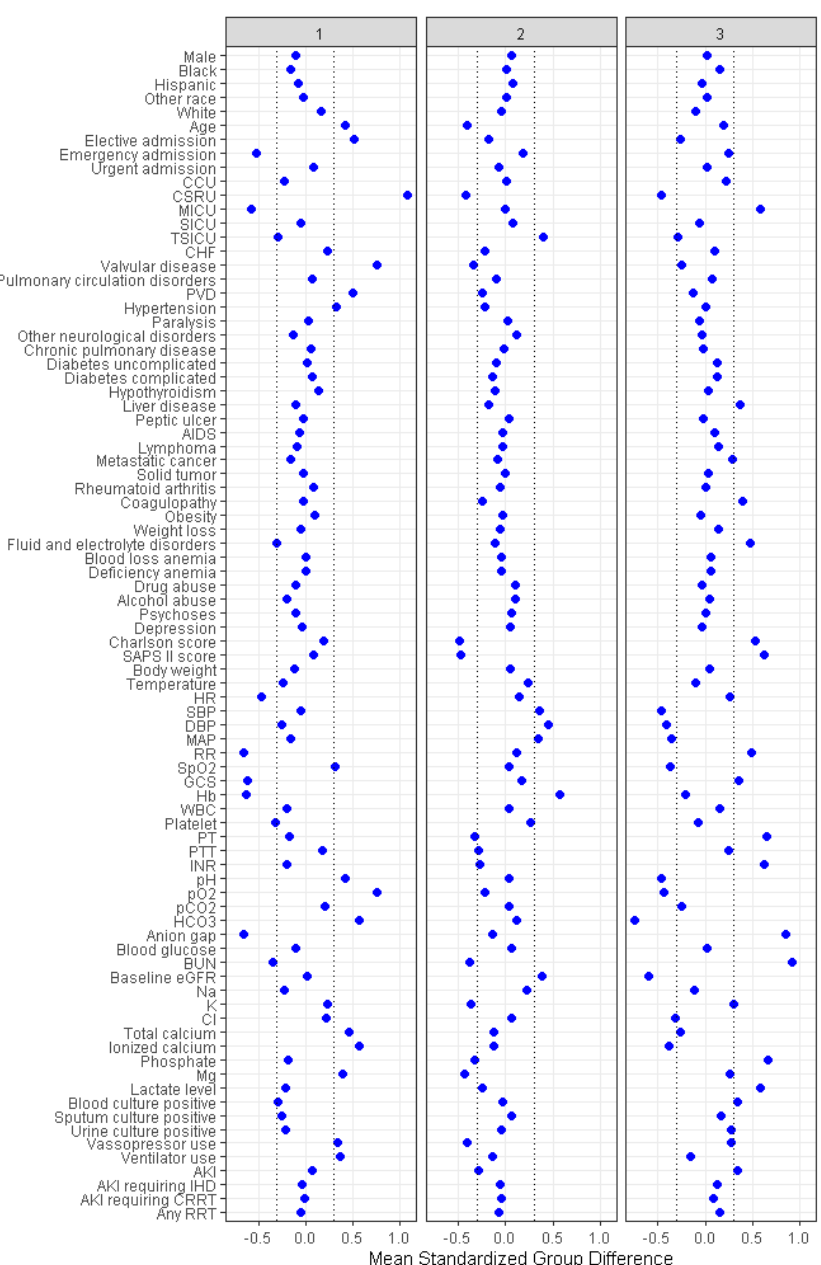
Figure 4. Standardized differences across the two clusters for each baseline variable for ICU patients with lactic acidosis. The X-axis represents the standardized differences value, and the Y-axis represents baseline variables. The dashed vertical lines signify the standardized differences cutoffs of < − 0.3 or >0.3. Abbreviations: AIDS, acquired immune deficiency syndrome; AKI, acute kidney injury; BUN, blood urea nitrogen; CCU, coronary care unit; CHF, chronic heart failure; Cl, chloride; CRRT, continuous renal replacement therapy; CSRU, cardiac surgery recovery unit; DBP, diastolic blood pressure; eGFR, estimated glomerular filtration rate; GCS, Glasgow coma scale; Hb, hemoglobin; HR, heart rate; ICU, intensive care unit; IHD, intermittent hemodialysis; INR, international normalized ratio; K, kalium (potassium); MAP, mean arterial pressure; Mg, magnesium; MICU, medical intensive care unit; Na, natrium (sodium); pH, potential of hydrogen; pCO 2 , partial pressure of carbon dioxide; pO 2 , partial pressure of oxygen; PT, prothrombin time; PTT, partial thromboplastin time; PVD, peripheral vascular disease; RR, respiratory rate; RRT, renal replacement therapy; SAPS II Score, Simplified Acute Physiology Score II; SBD, SPO 2 , saturation of peripheral oxygen; SBP, systolic blood pressure; SICU, surgical intensive care unit; WBC, white blood